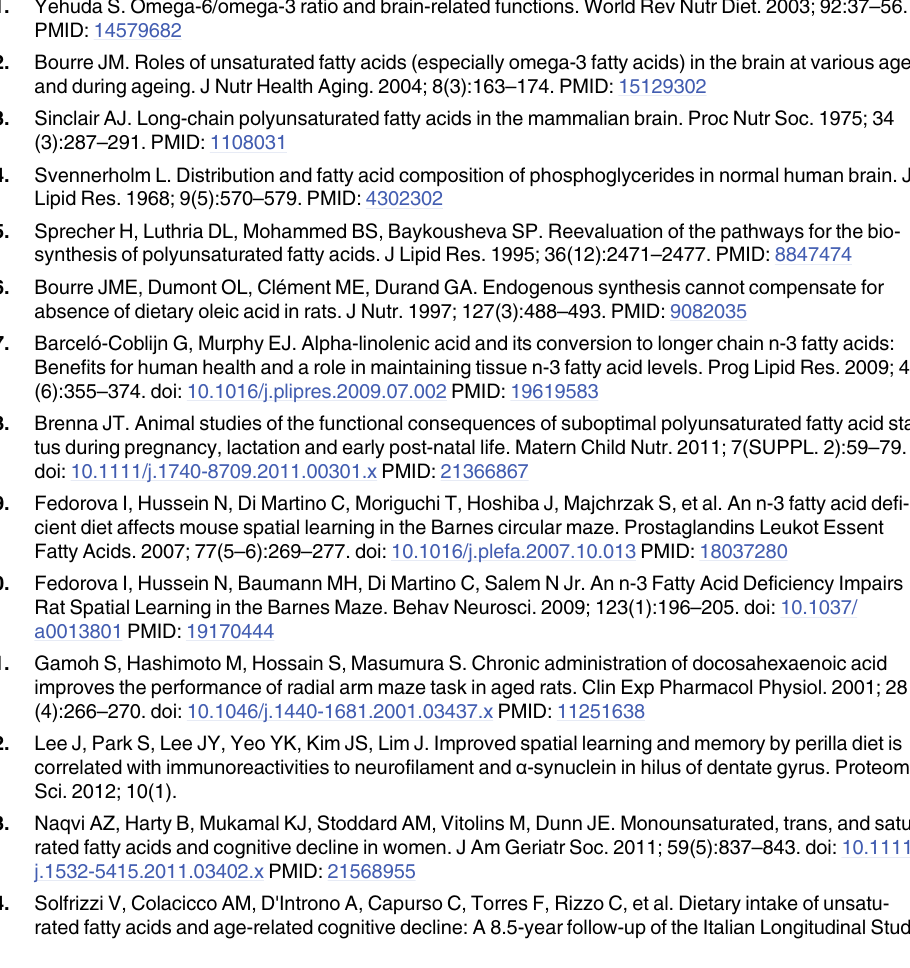
S1 Table. Model statistics for behaviors of the spatial cognition test and saliva cortisol con- centrations. S2 Table. Plasma fatty acids (% on total fatty acids) for single male and female groups.